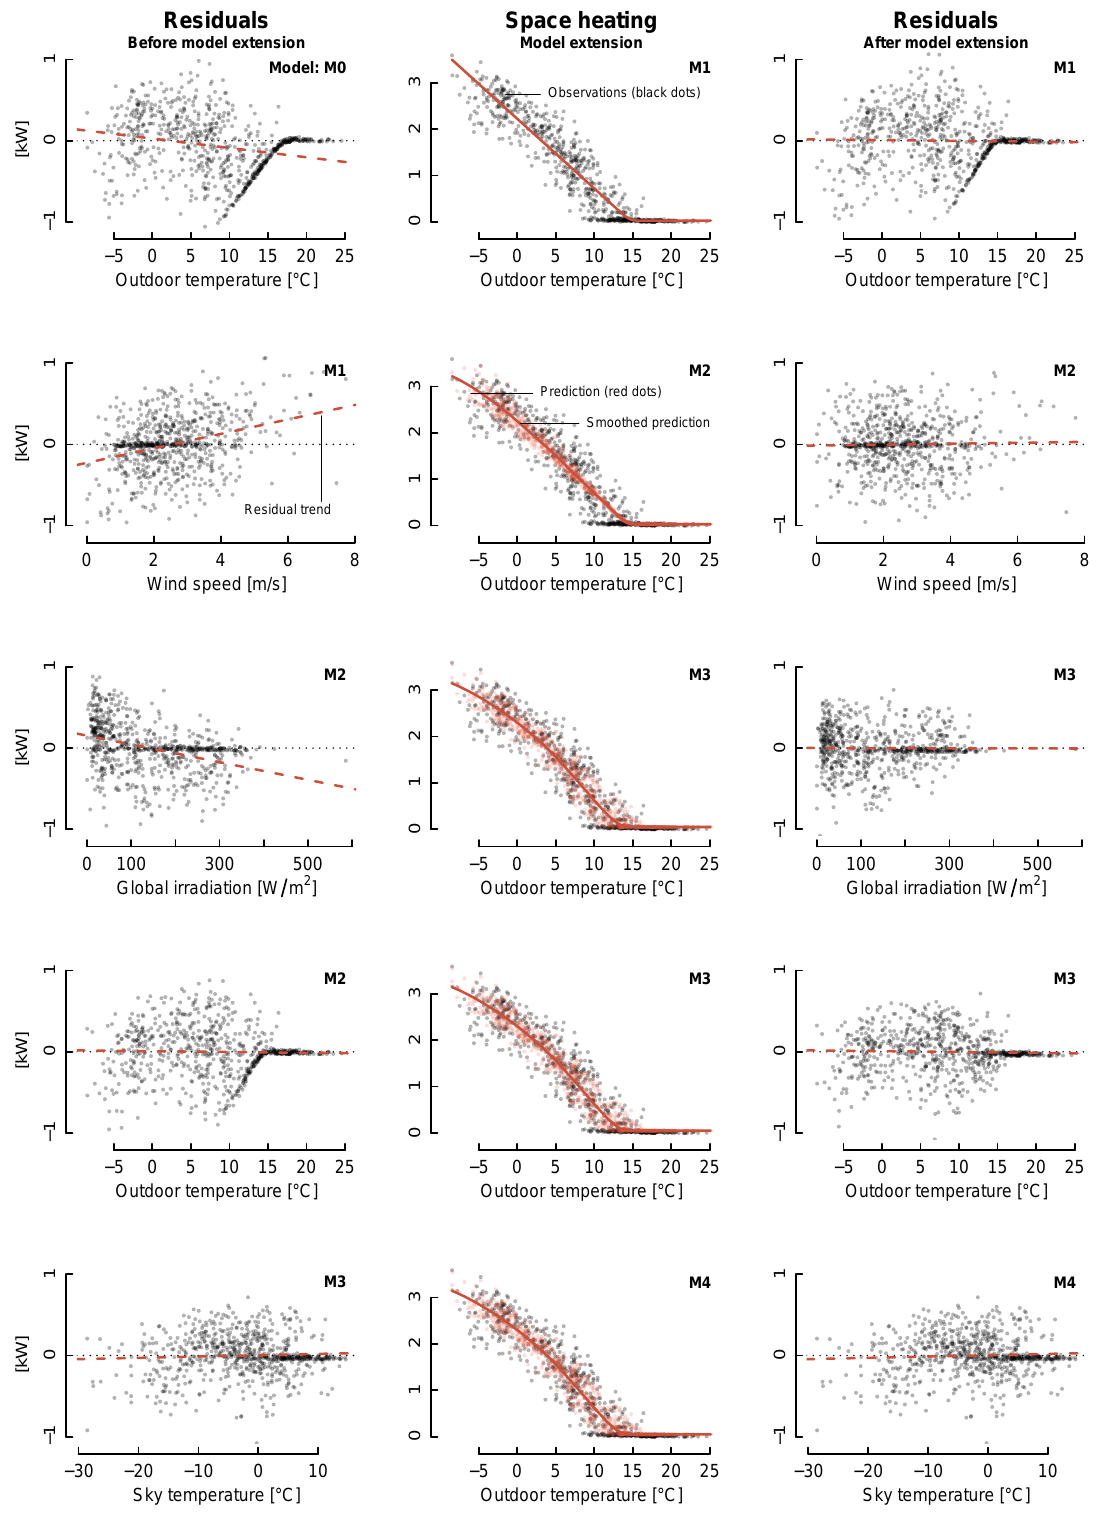
Figure 3. Forward model selection for House 6. The figure shows the effect of a particular model extension, starting with the model residuals of Model M0 in the top-left corner. The figure is read row-wise and each row represents a model extension. The model formulations of the model names in the top-left corner of the individual plot can be found in Table 1. Notice that the x -axis of the residuals plots changes depending on the model